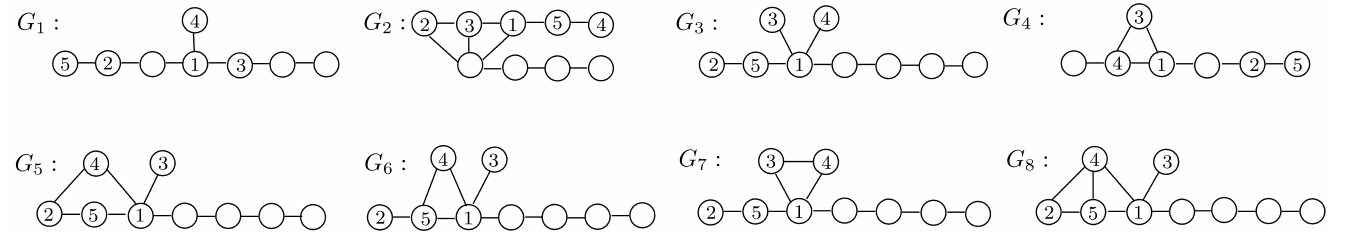
for 1 ≤ i ≤ 8 in the proof of Proposition i